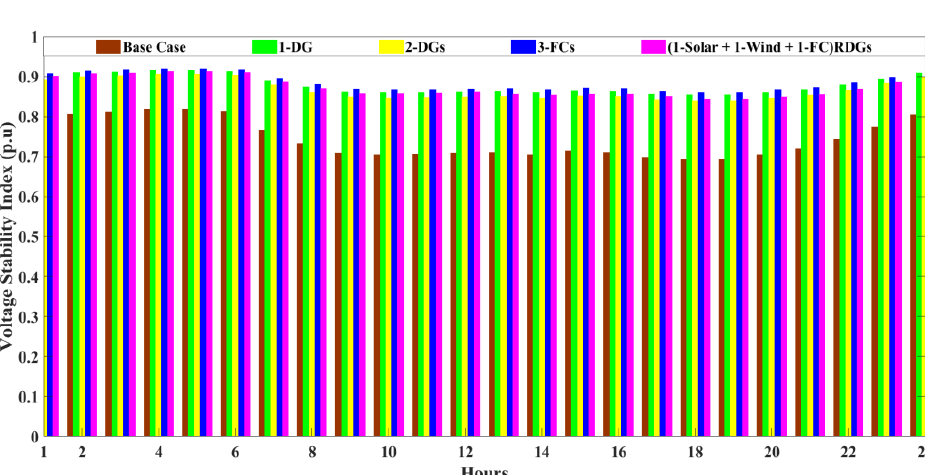
Figure 14. Voltage Profile characteristic for a typical day.